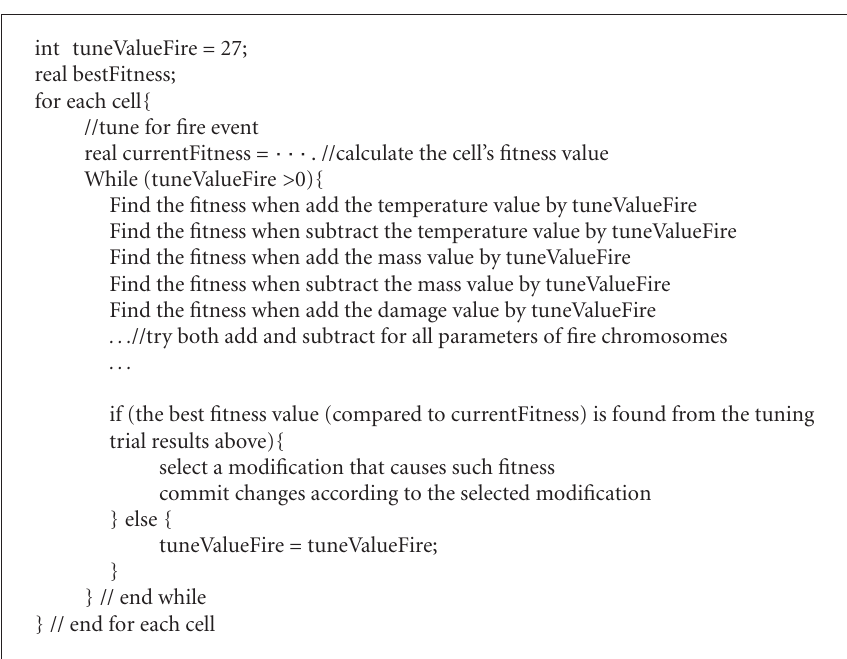
Algorithm 1: Pseudocode for steepest ascent hill-climbing on fire related